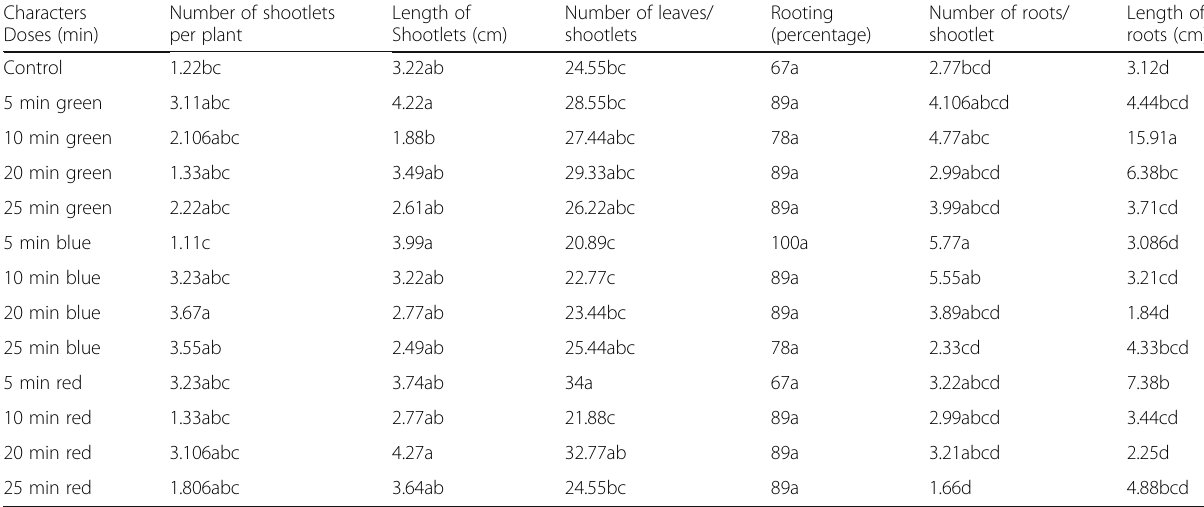
Table 2 Effect of laser radiation on in vitro shooting and rooting behaviors of Eustoma grandiflorum plant Characters Doses